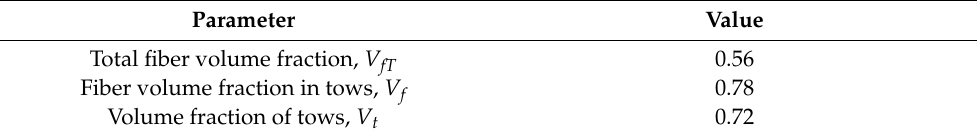
Table 7. The volume fraction parameters of the T300/Epoxy PWF